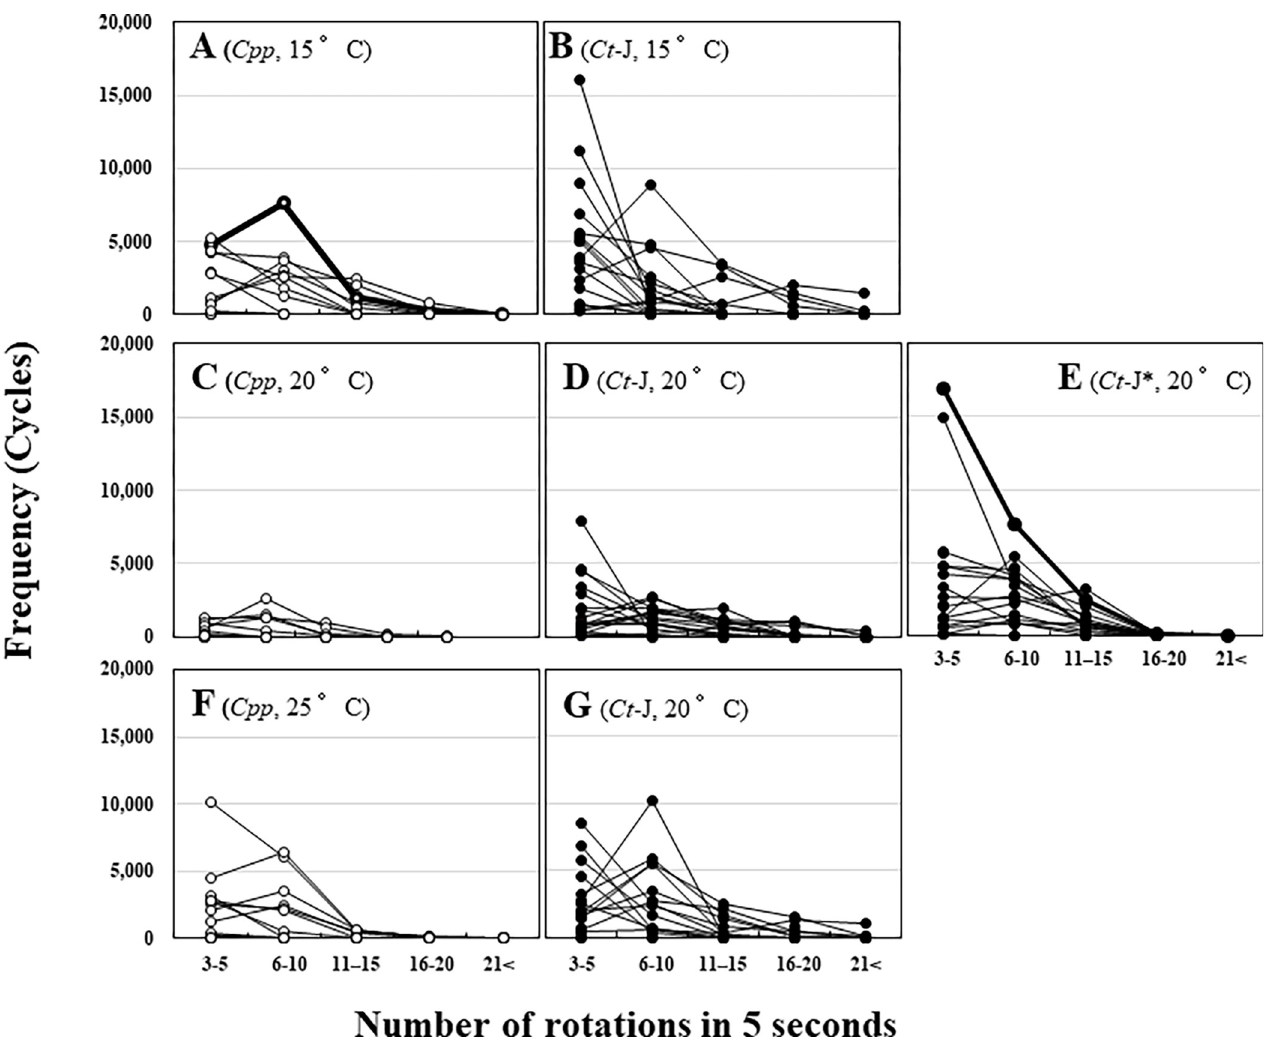
Fig 6. The frequencies of rotations within 5 s in the flight mill experiments between Cx . tritaeniorhynchus ( Ct -J, closed circles) and Cx . p . pallens ( Cpp , open circles). A : Cpp at 15˚C, B : Ct -J at 15˚C, C : Cpp at 20˚C, D : Ct -C at 20˚C, E : Ct -J � ( Ct -J females were reared at 25˚C, but flight experiments were conducted at 20˚C) at 20˚C, F : Cpp at 25˚C, Ct -C at 25˚C. Bold lines indicate the longest total flight time in each condition of Cpp at 15˚C ( A ) and Ct -J � at 20˚C ( E